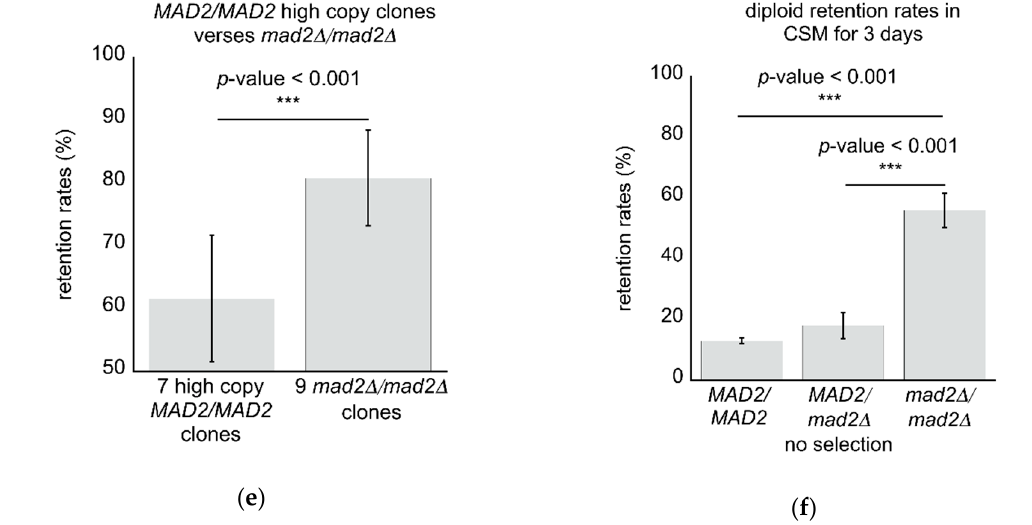
Figure 6. Mutant mad2 ∆ / mad2 ∆ diploid clones display suppression of clone-to-clone di ff erences and have high retention rates even in the absence of selection: ( a ) The measured average artificial linear chromosome copy number per cell versus the measured retention rates ( n = 8 qPCR; n = 6 retention rate) where values are displayed as the mean ± standard deviation for 10 MAD2 / MAD2 genetically identical diploid clones. One clone (SCSY1057; marked with an arrow) had undergone an integration event and was excluded from further analyses; ( b ) The measured average artificial linear chromosome copy number per cell versus the measured retention rates ( n = 8 qPCR; n = 6 retention rate) where values are displayed as the mean ± standard deviation for 9 MAD2 / mad2 ∆ genetically identical diploid clones. All clones uniformly display a low retention rate but separated into high copy, mid-level copy, and low copy groups; ( c ) The measured average artificial linear chromosome copy number per cell versus the measured retention rates ( n = 8 qPCR; n = 6 retention rate) where values are displayed as the mean ± standard deviation for 9 mad2 ∆ / mad2 ∆ genetically identical diploid clones that suppress the clone-to-clone di ff erences. All clones cluster into a single group with a mid-level copy number and high retention rates; ( d ) A direct comparison between MAD2 / MAD2 and mad2 ∆ / mad2 ∆ haploid clones of average artificial linear chromosome copy number per cell versus the measured retention rates where values are displayed as the mean ± standard deviation; ( e ) the retention rates of artificial linear chromosomes in mad2 ∆ / mad2 ∆ are significantly higher compared to wild type MAD2 / MAD2 high copy clones ( p -values < 0.001 denoted by ***, Student’s t -test), even though the chromosome copy numbers are not di ff erent ( p -value = 0.5354, Student’s t -test); ( f ) in cells grown for 3 days in CSM in the absence of selection, mad2 ∆ / mad2 ∆ cells displayed a significantly higher retention rate for the artificial linear chromosomes compared to both wild type MAD2 / MAD2 and mutant MAD2 / mad2 ∆ clones in a manner very similar to mad2 ∆ haploid clones ( p -value < 0.001 and < 0.001 denoted by ***, Student’s t -test).